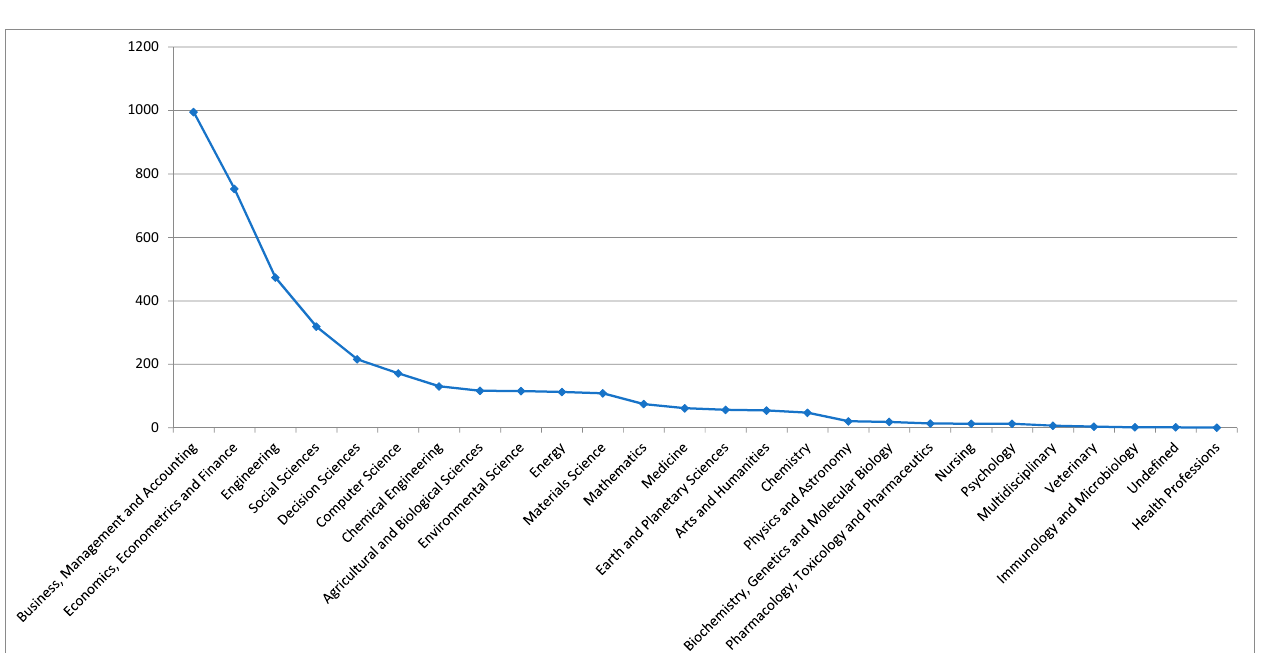
Figure 3. Distribution of records by areas of search (WoS).